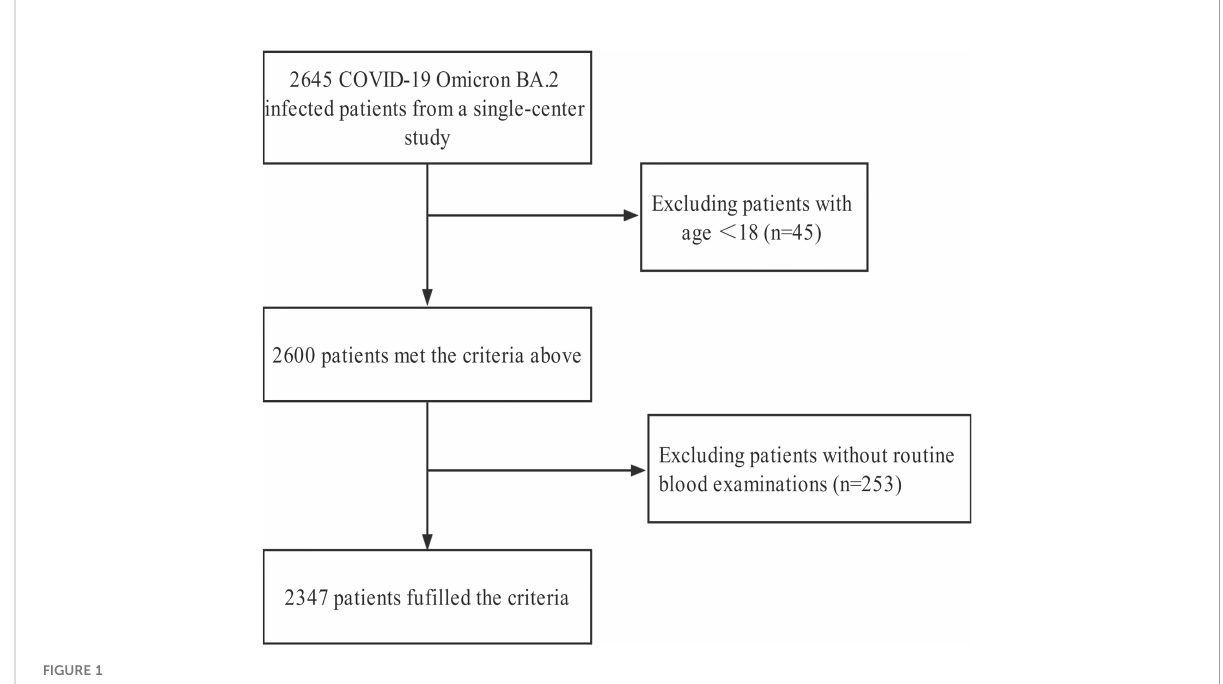
FIGURE 1 Flowchart of the patient selection